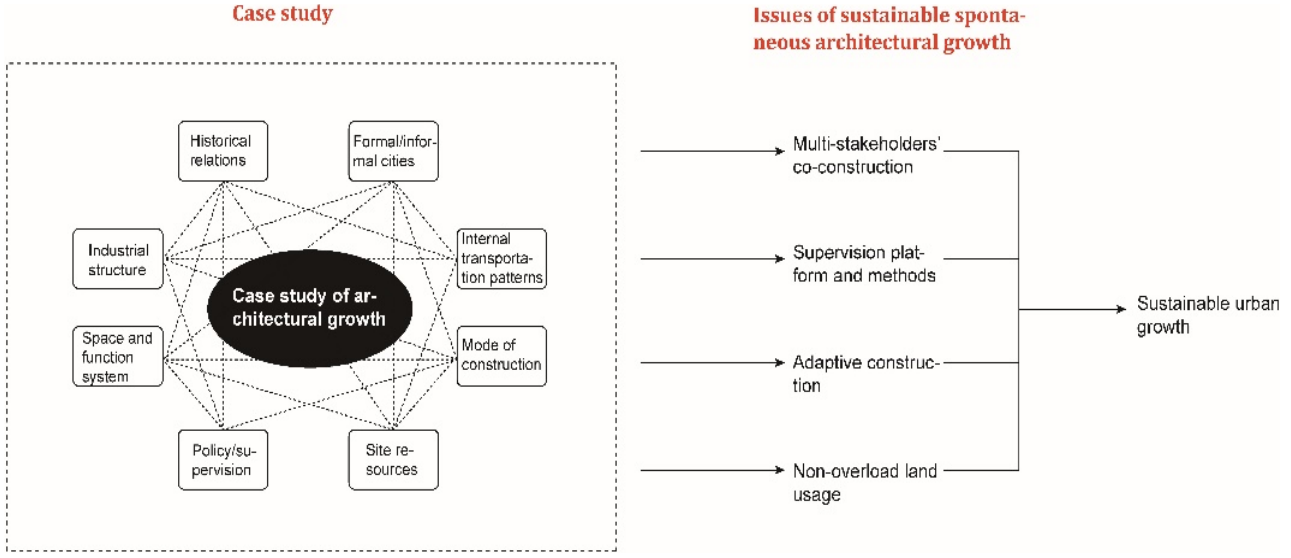
Figure 5. The elements of spontaneous architectural growth clarified by case analysis from the perspective of sustainability (Source: author).